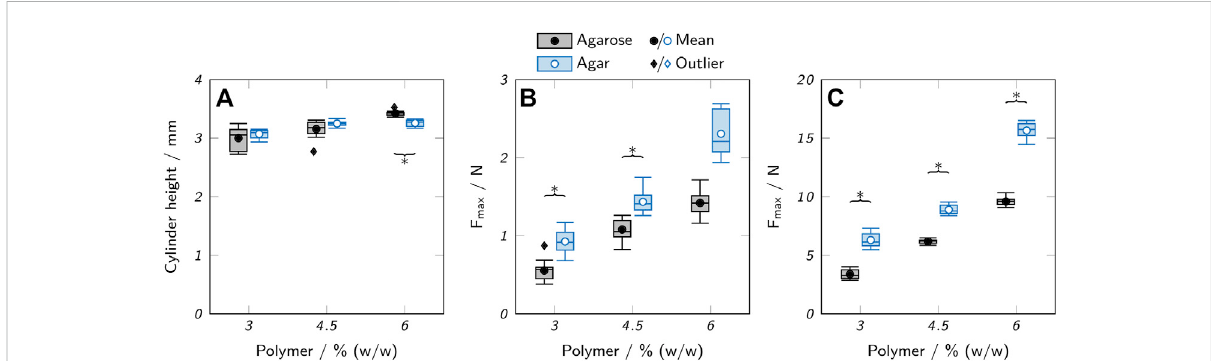
FIGURE 7 Mechanical testing of low-melt agarose and agar hydrogels. (A) Height of printed hydrogel cylinders. (B,C) Maximum applicable compression force F max before rupture of (B) printed hollow hydrogel cylinders and (C) cast hydrogel samples. The box plots represent the median and the upper and lower quartile. The whiskers represent the most extreme value still within a 1.5-fold interquartile range (IQR) from the upper and lower quartile. All data points outside the 1.5-fold IQR are depicted as outliers. Each box represents twelve samples ( n = 12). Signi fi cant differences between agarose and agar are highlighted by asterisks ( p <